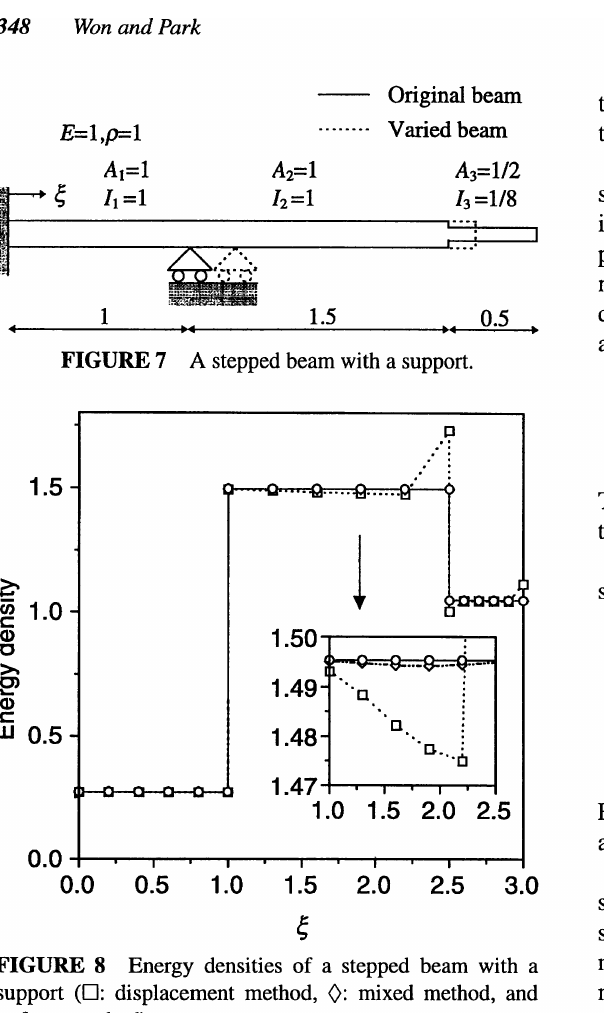
FIGURE 7 A stepped beam with a support.